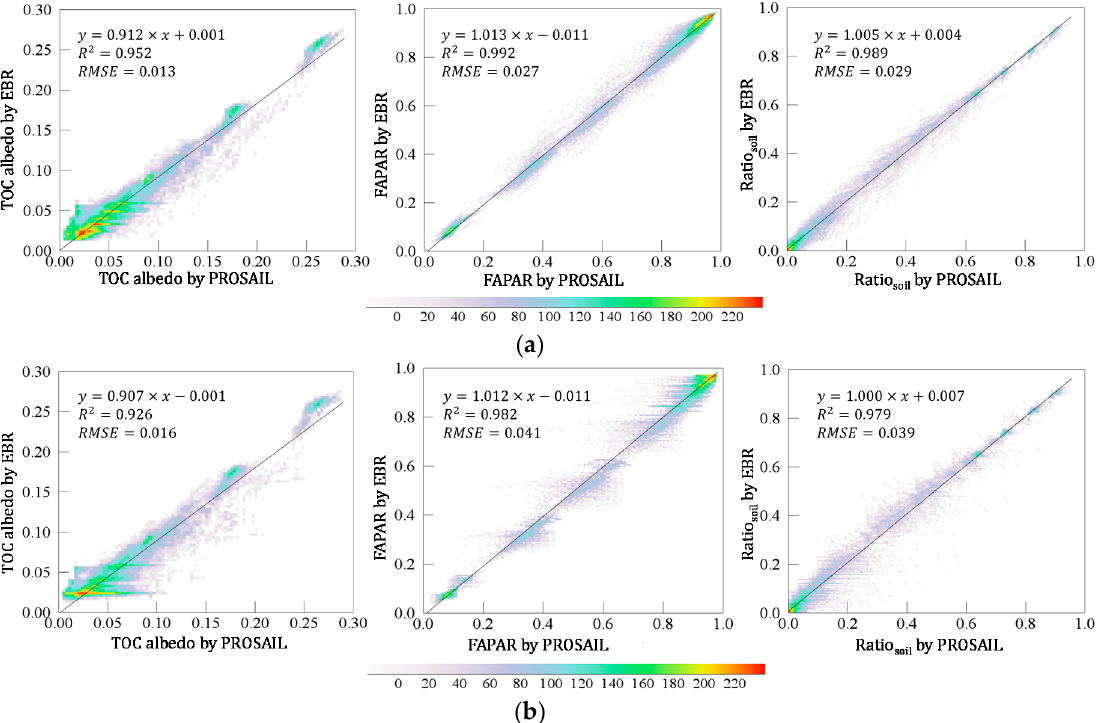
Figure 6. Evaluation of the EBR approach using the 81,000 simulations by PROSAIL. ( a ) “True” values of the leaf extinction coefficient (k), (cid:1827)(cid:1864)(cid:1854)(cid:1857)(cid:1856)(cid:1867) (cid:3043)(cid:3048)(cid:3045)(cid:3032) , and G( θ ) were available from PROSAIL simulations, ( b ) the prior parameters were fixed ( k = 0.88, G( θ ) = 0.5, (cid:1827)(cid:1864)(cid:1854)(cid:1857)(cid:1856)(cid:1867) (cid:3043)(cid:3048)(cid:3045)(cid:3032) =